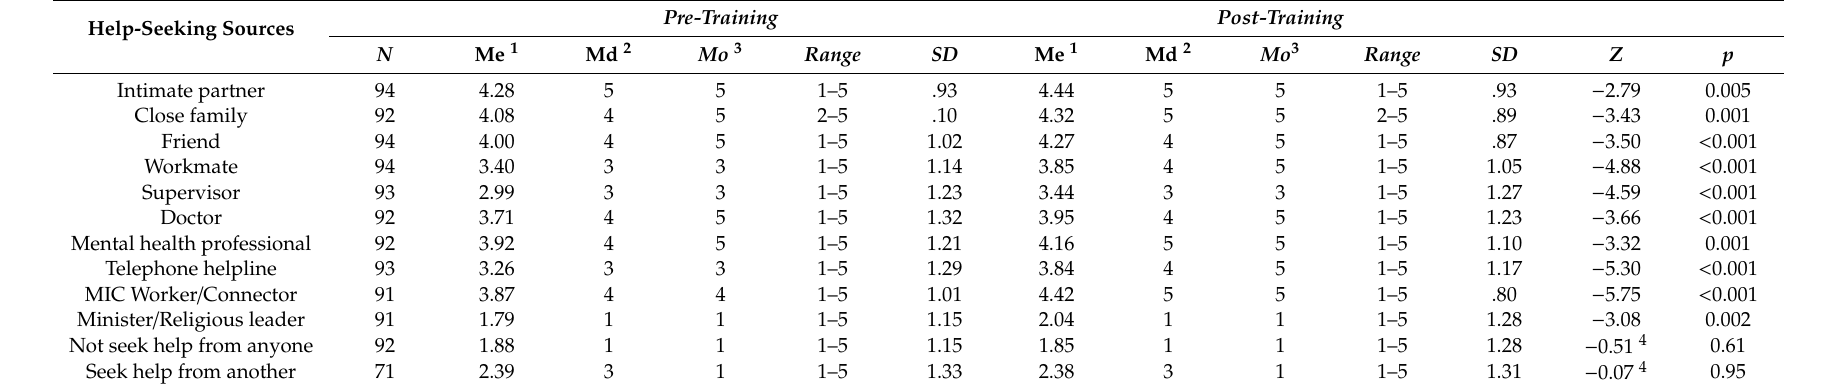
Table 2. Help-seeking intentions: pre- and post-connectors’